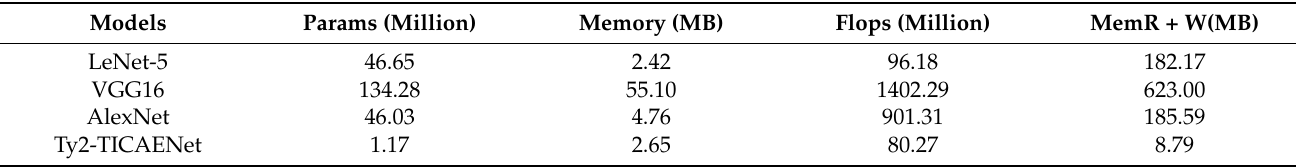
Figure 5. The overall architecture of the Ty2-TICAENet. Table 5. Comparison different model